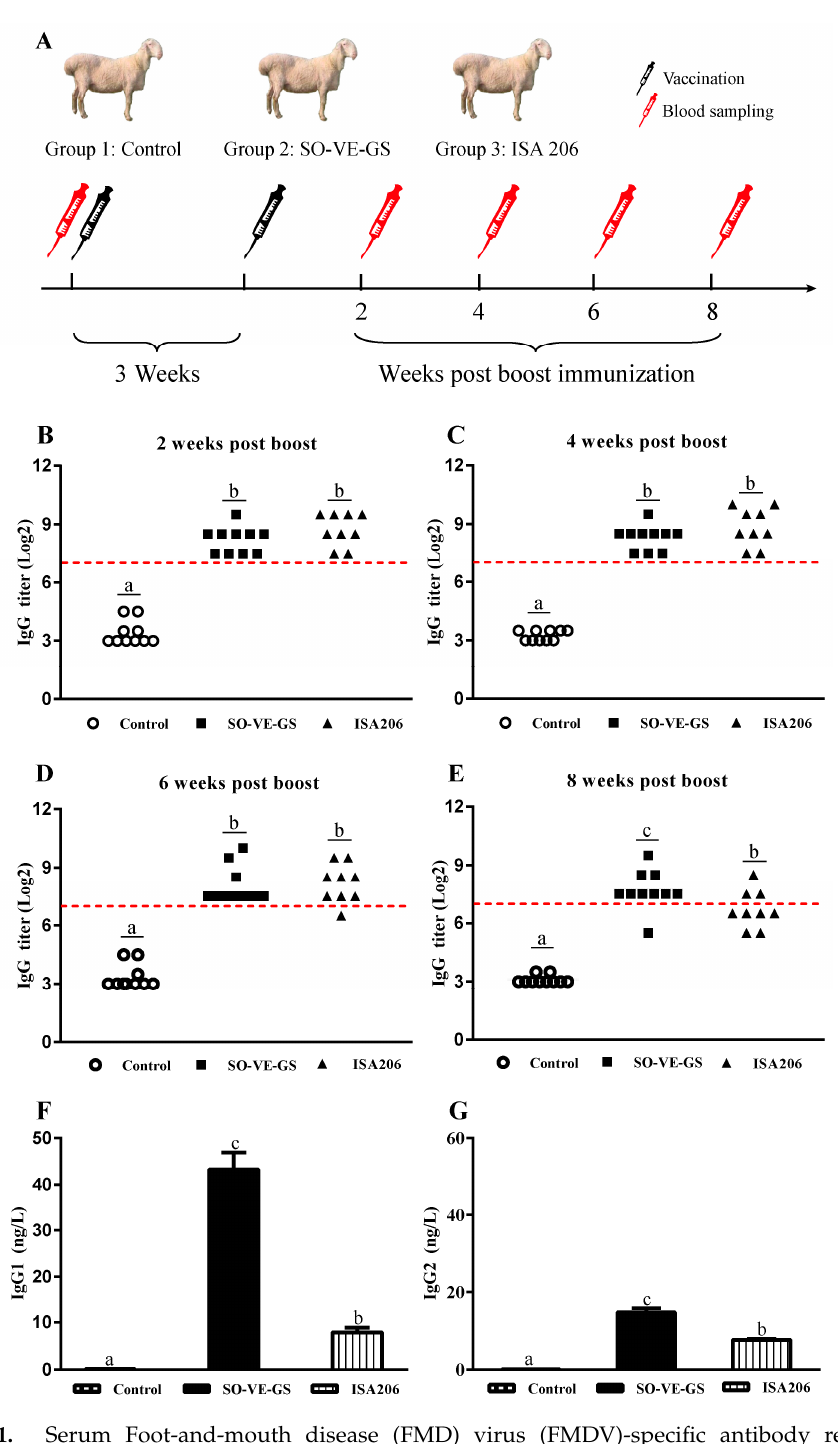
Figure 1. Serum Foot-and-mouth disease (FMD) virus (FMDV)-specific antibody response. ( A ) Experimental design: Hu sheep were intramuscularly (i.m.) immunized twice at a 3-week interval with FMD vaccine emulsified in a vegetable oil consisting of soybean oil, vitamin E, and ginseng saponins (SO-VE-GS) (n = 10) or ISA 206 (n = 9), and sheep without immunization served as control (n = 10). Blood samples were taken prior to vaccination and at 2, 4, 6, and 8 weeks after the booster immunization to detect serum FMDV-specific IgG. ( B – E ) FMDV-specific IgG titers determined at 2, 4, 6, and 8 weeks post the booster; dotted horizontal line was at an IgG titer of 1:128, indicating the minimum protection titer. ( F – G ) IgG1 and IgG2 measured at 8 weeks post the booster. The values are presented as mean ± SE. Data with different letters are statistically different ( P < 0.05).